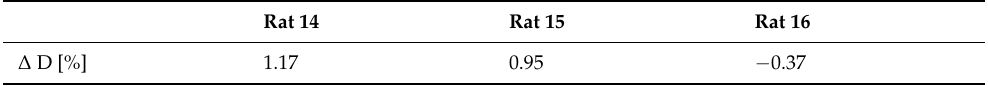
Figure 12. Exemplary comparison of PVDR computed from MC simulation and ML predic- tion. ( a ) ∆ PVDR is calculated as ( PVDR ML − PVDR MC ) / PVDR ML for each macrovoxel (see Section 2.2). ( b ) Red arrows in the relative PVDR deviation subplot indicate deviations larger than the shown ranges. Table 3. Deviation in delivered dose ( ∆ D ) due to a difference in predicted minimum valley dose between ML prediction and MC simulation in the entire prediction region (8 × 8 cm 2 field